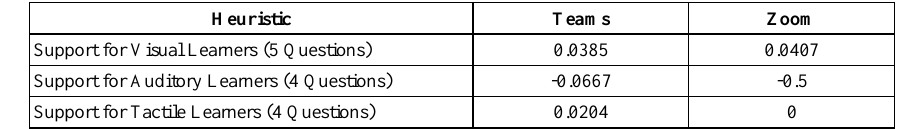
Table 8. Survey results for category 2 Heuristics (Cognitive style criteria) – numbers show Fleiss’s Kappa interrater agreement score among the three learners (auditory, visual and tactile) for each Heuristic Heuristic Teams